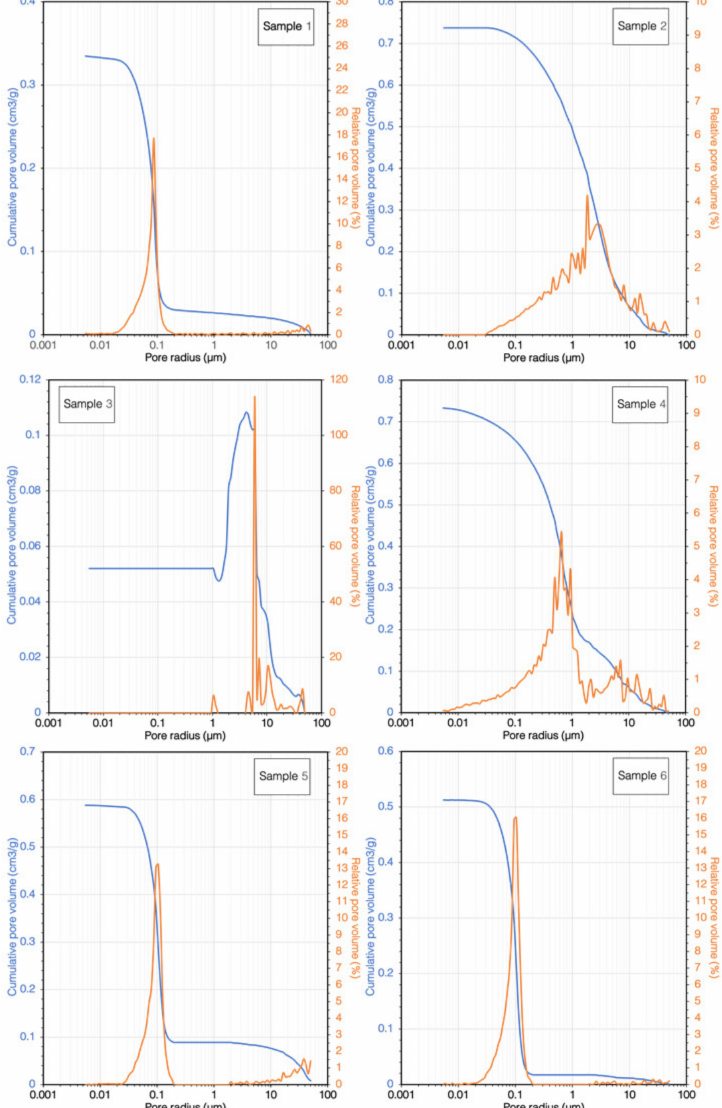
Figure 5. Pore size distributions of all six samples quantified by mercury porosimetry